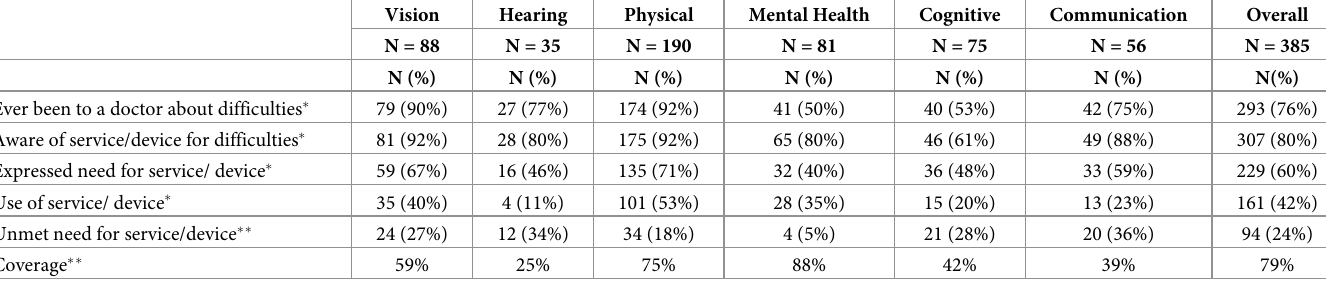
Table 4. Met and unmet needs for disability-related healthcare among people with disabilities by functional